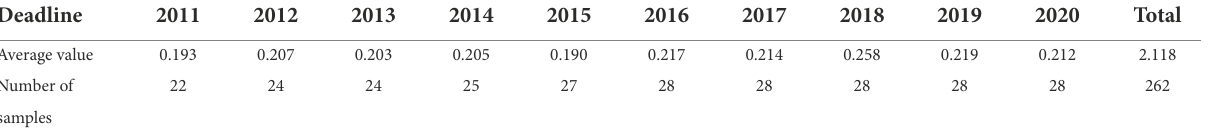
TABLE 2 Average value of high-quality development in the past 10